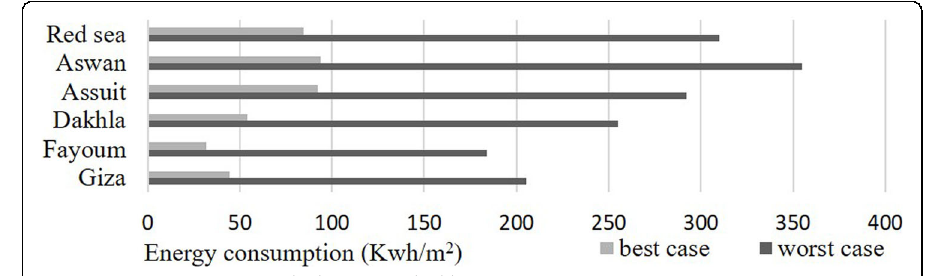
Fig. 6 Energy consumption in the best/ worst building